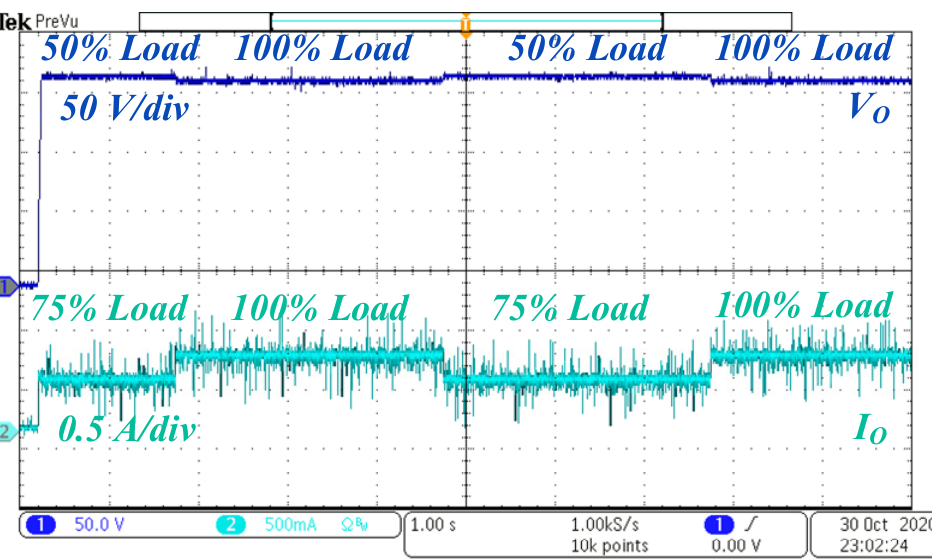
Figure 21. E ff ect of change in load on V O and I O Figure 21. Effect of change in load on V O and I O . Figure 21. Effect of change in load on V O and I O .